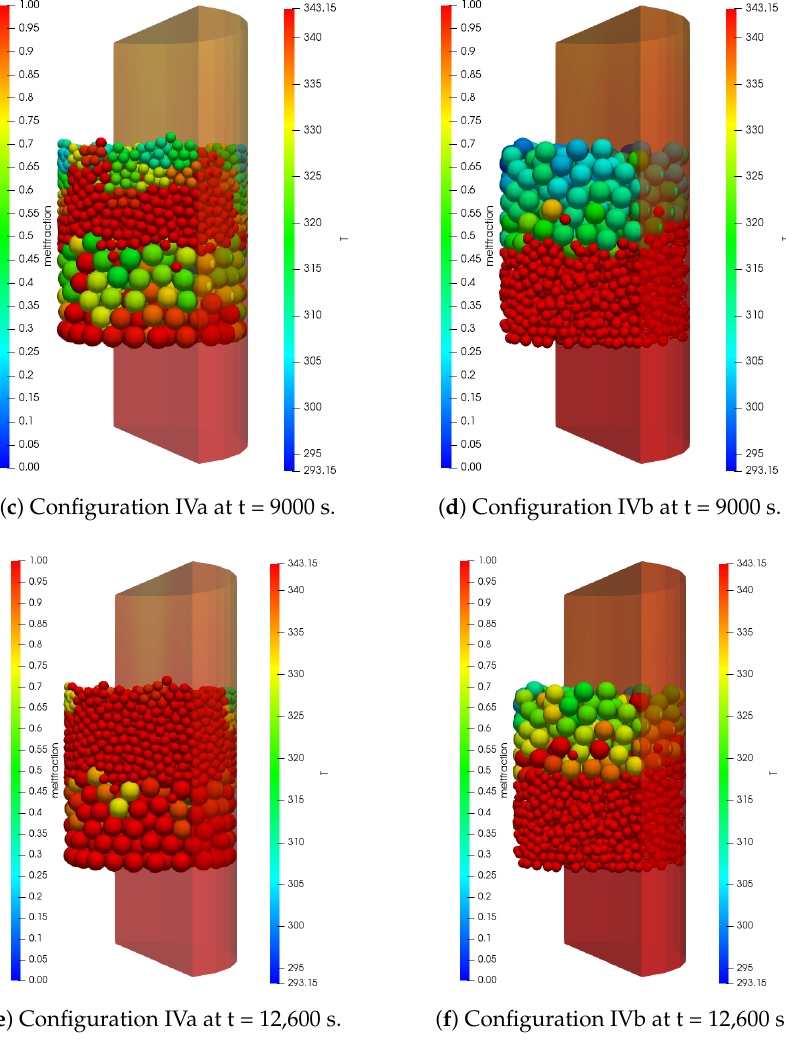
Figure 12. Comparison of melt fraction for both versions of Configuration IV.